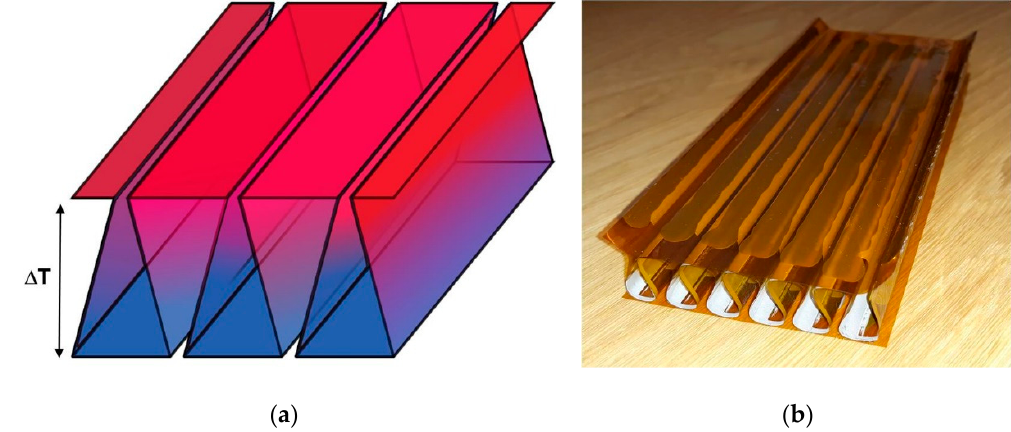
Figure 1. ( a ) A sketch of the three-dimensional structure of the folded TEG module with the color-coding indicating the temperature gradient ( Δ T ) over the module (blue = “cold”, red = “hot”); ( b ) The fabricated folded TEG module of 11 TEG elements connected electrically in series on the substrate that is folded to assemble the elements thermally in